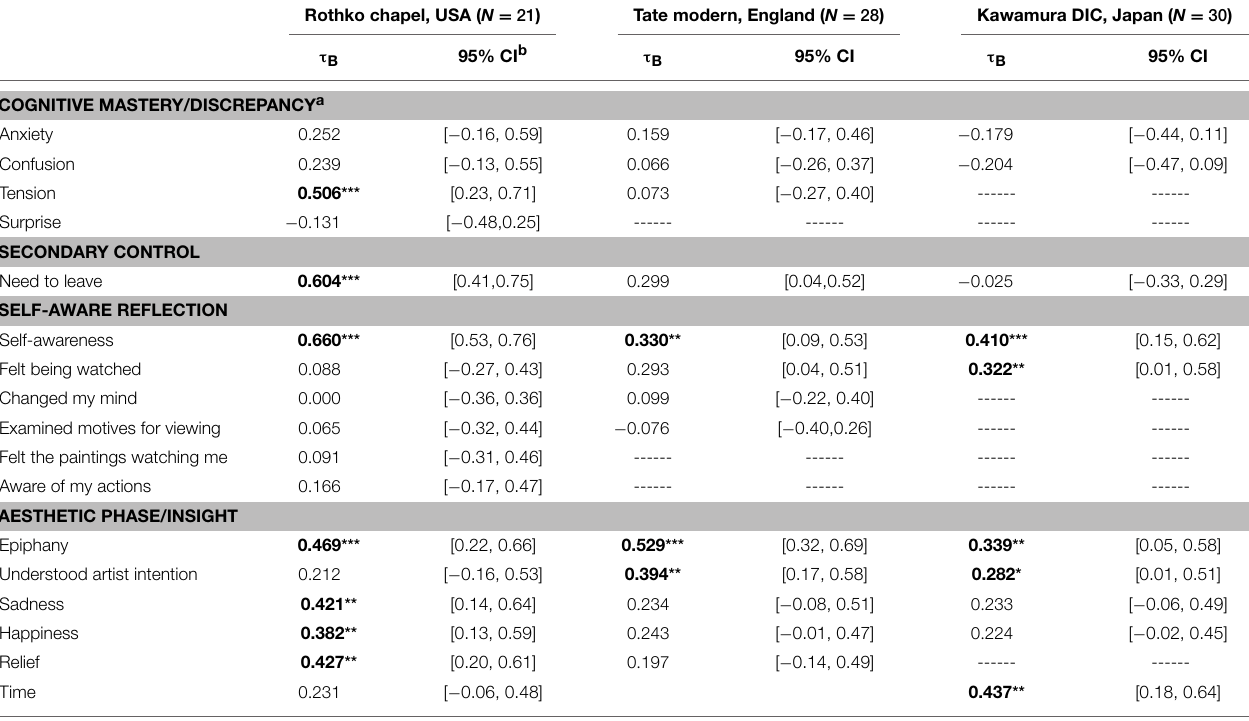
TABLE 2 | Correlation of reported “felt like crying” and other experiential/emotional factors in three encounters with museum